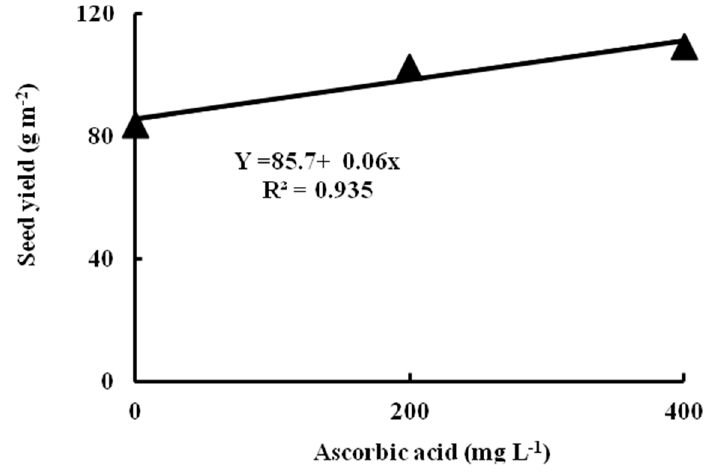
Figure 1. The response curve of common bean plants to ascorbic acid (AsA) applications amounts grown under two water management (WM) treatments.